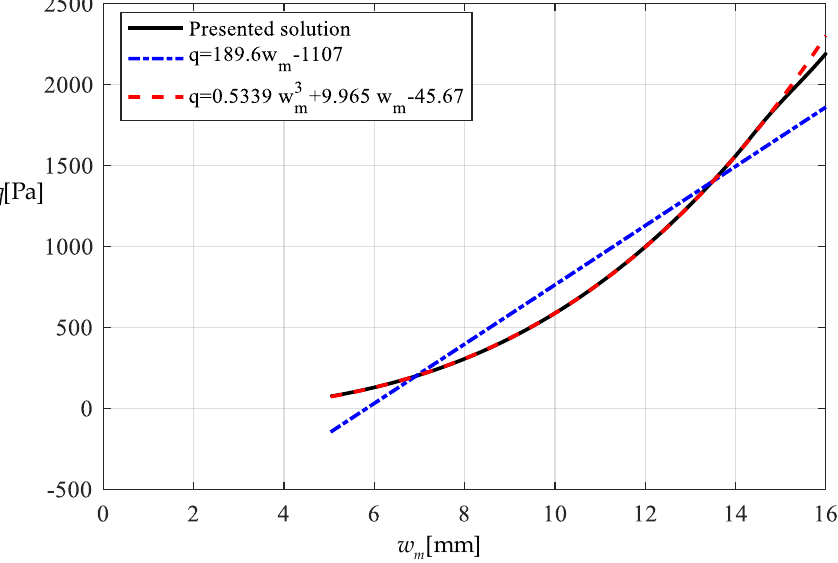
Figure 17. Variations of q with w m